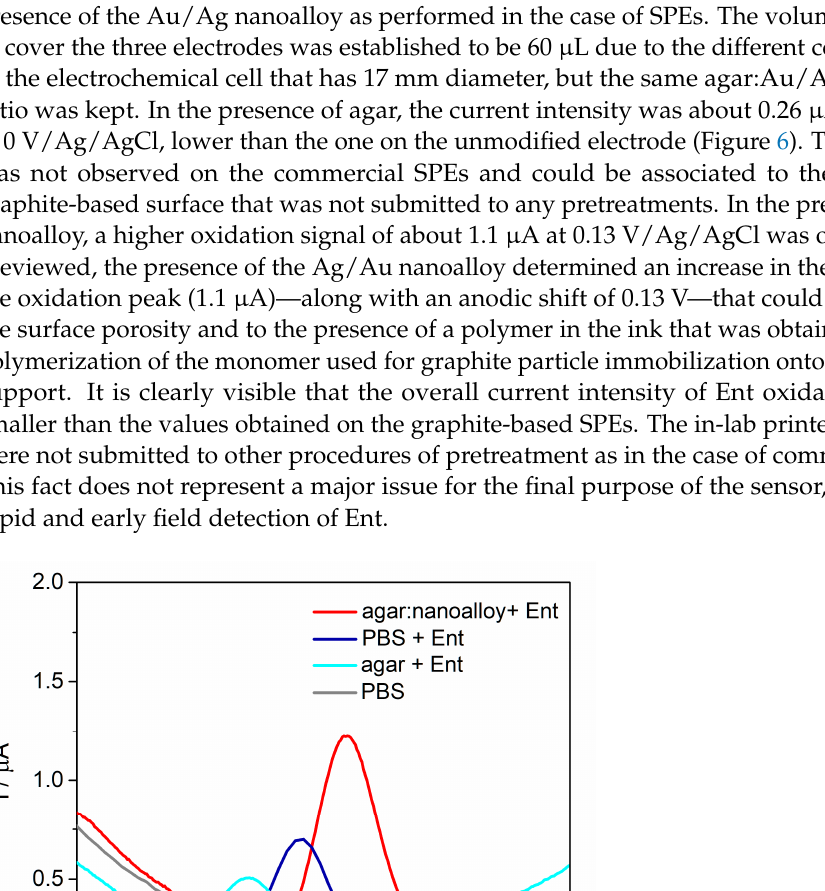
Figure 7. DPV for 25 μ M Ent on agar:Au/Ag nanoalloy platform developed on ( a ) commercially available graphite SPE; ( b ) in ‐ lab printed electrode on thin flexible substrate; ( c ) in ‐ lab printed electrode on medical glove. Given the promising results obtained on graphite ‐ based commercial SPEs for the detection of PyoC in previous studies [32] and Ent, this configuration was assessed for the individual, respectively simultaneous detection of both bacteria markers. In the presence of PyoC, a specific peak appeared at − 0.4 V/Ag/AgCl consistent with prior published results [32].